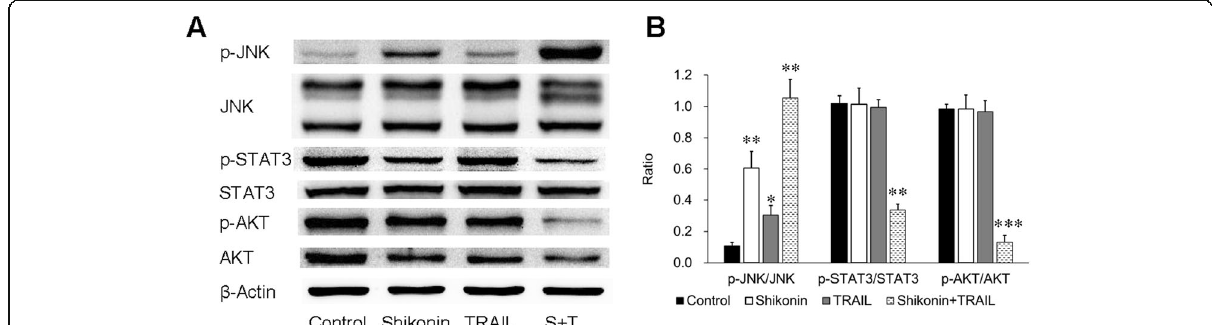
Fig. 4 Phosphorylation effect of shikonin and TRAIL on JNK, STAT3 and AKT. a Activation of JNK and inhibition of STAT3 and AKT were associated with the induction of apoptosis in A549 cells by shikonin and TRAIL cotreatment as described above. The expression of the total and phosphorylated forms of JNK, STAT3 and AKT were assessed using the corresponding antibodies via Western blotting. b The data are presented as the means ± SDs of at least three independent experiments, and significant differences between the control group and the other groups are shown as * p <0.05, ** p <0.01 and *** p <0.001. S+T: Shikonin +